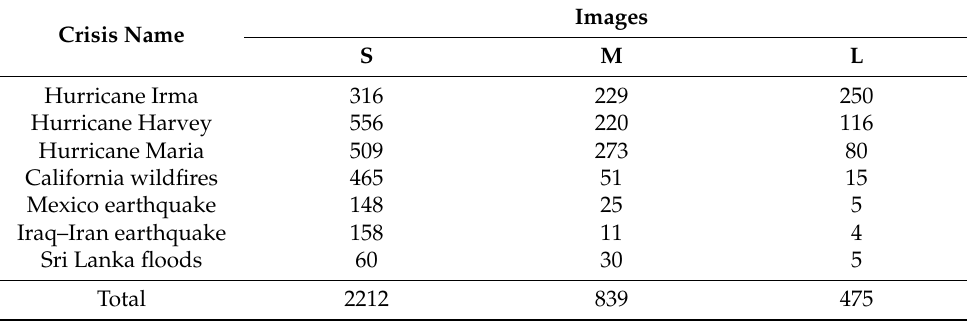
Table 4. The dataset of crisis and its severity for Task